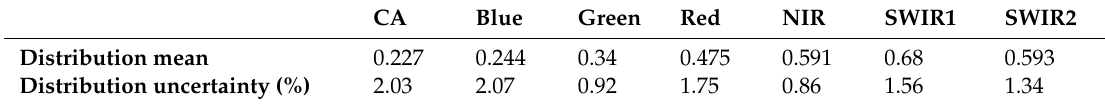
Table 4. Distribution mean and uncertainty for worst case scenario (single location). CA Blue Green Red